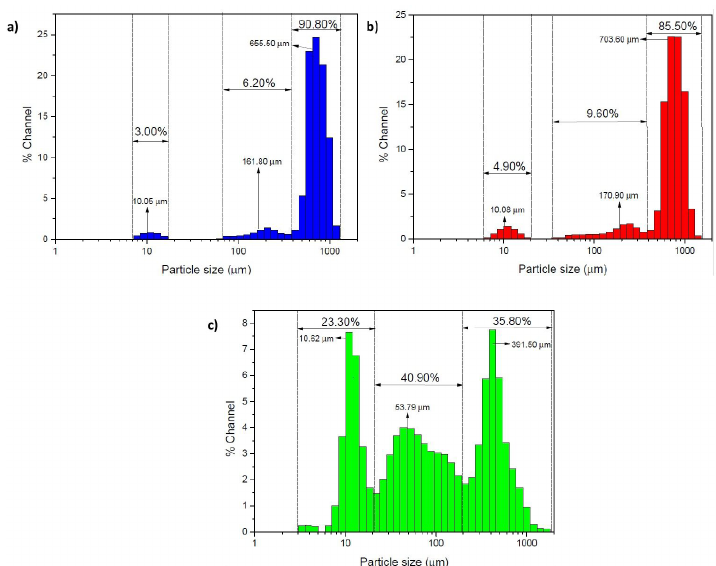
C addition for (a) 4 hours (b) 8 hours (c) 12 2